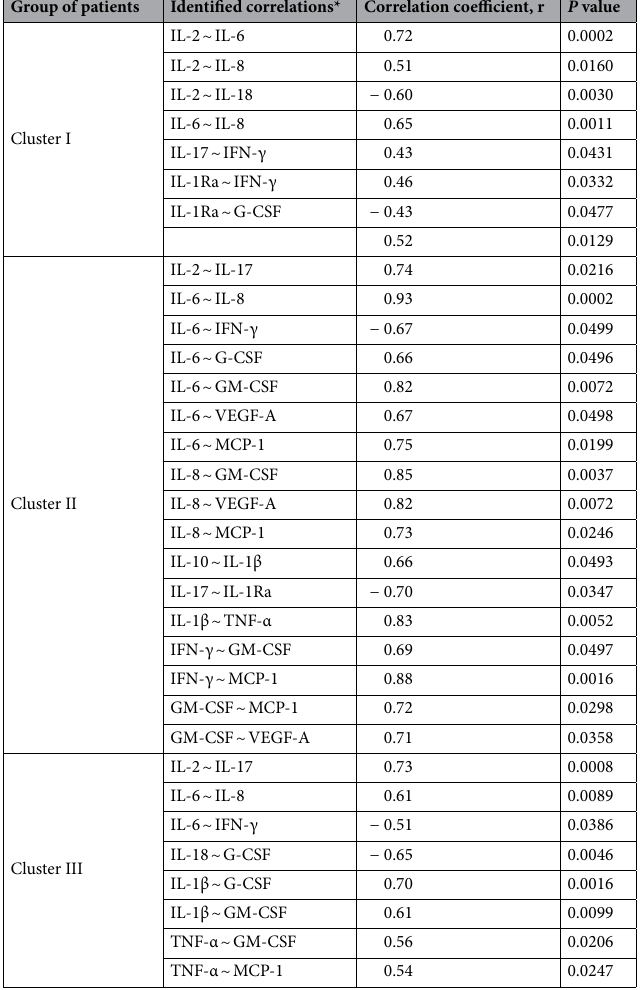
Table 4. Correlations between the parameters of cytokine production by the IBC-NST biopsy samples. *Spearman correlation